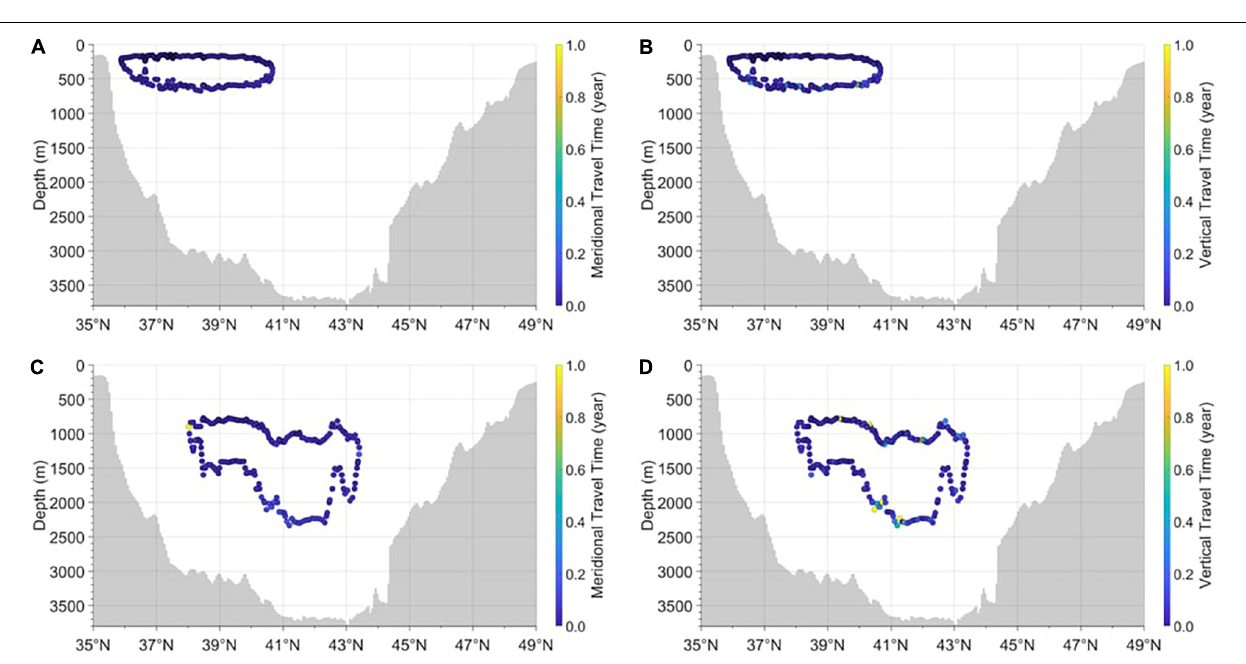
FIGURE 7 | Meridional and vertical travel times of 0.3 Sv (A,B) and 0.13 Sv (C,D) streamlines for the deep convection case in the meridional overturning stream function. Turnover times of the 0.3 Sv (A,B) and 0.13 Sv (C,D) streamlines are 26.41 years (= 11.79 + 14.62) and 37.28 years (= 13.28 + 24.00), respectively.